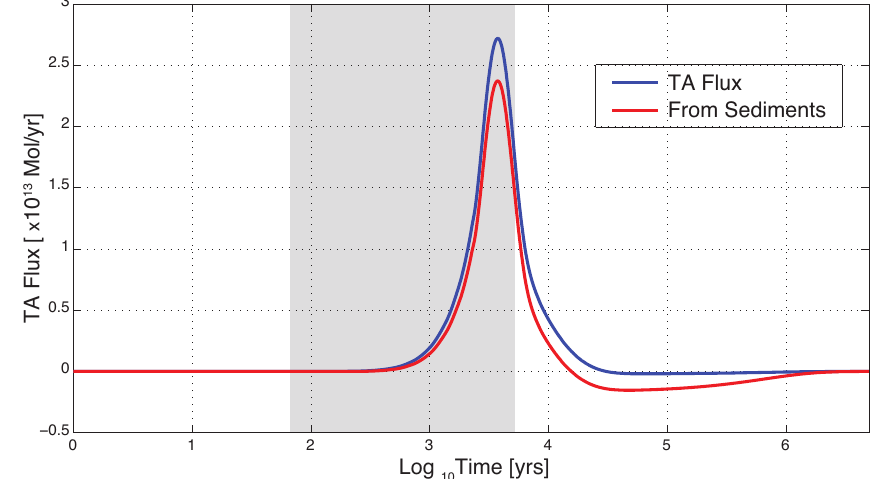
Figure 6. Time rate of change in global total alkalinity (TA) for the case of E = 1000PgC and D = 5kyr. Shaded region indicates time of emission. Blue curve is the time rate of change in global ocean TA. Red curve shows the blue curve minus the TA flux that is due to weathering feedbacks.